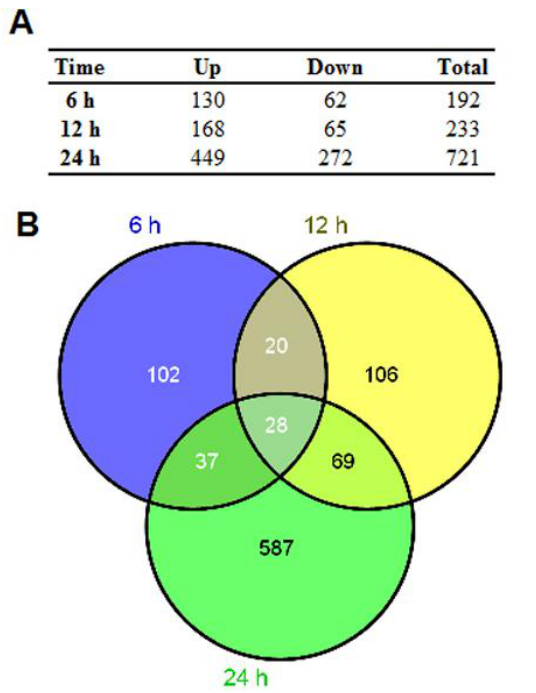
Figure 2. Summary of genes differentially expressed in response to HM/06. ( A ) U251 cells were infected by HM/06 at MOI 1.0. At times 6, 12, and 24 hpi, total RNA was extracted and transcriptional profiles were assessed using 4 × 44K Agilent whole human genome oligo microarray carried by a commercial Agilent array service. Genes with Fold change ≥ 2.0 and p < 0.05 in response to HM/06 infection compared with control were indentified to be differentially expressed; ( B ) Over-lapping DE genes at each time post-infection were analyzed by VENNY 2.0.